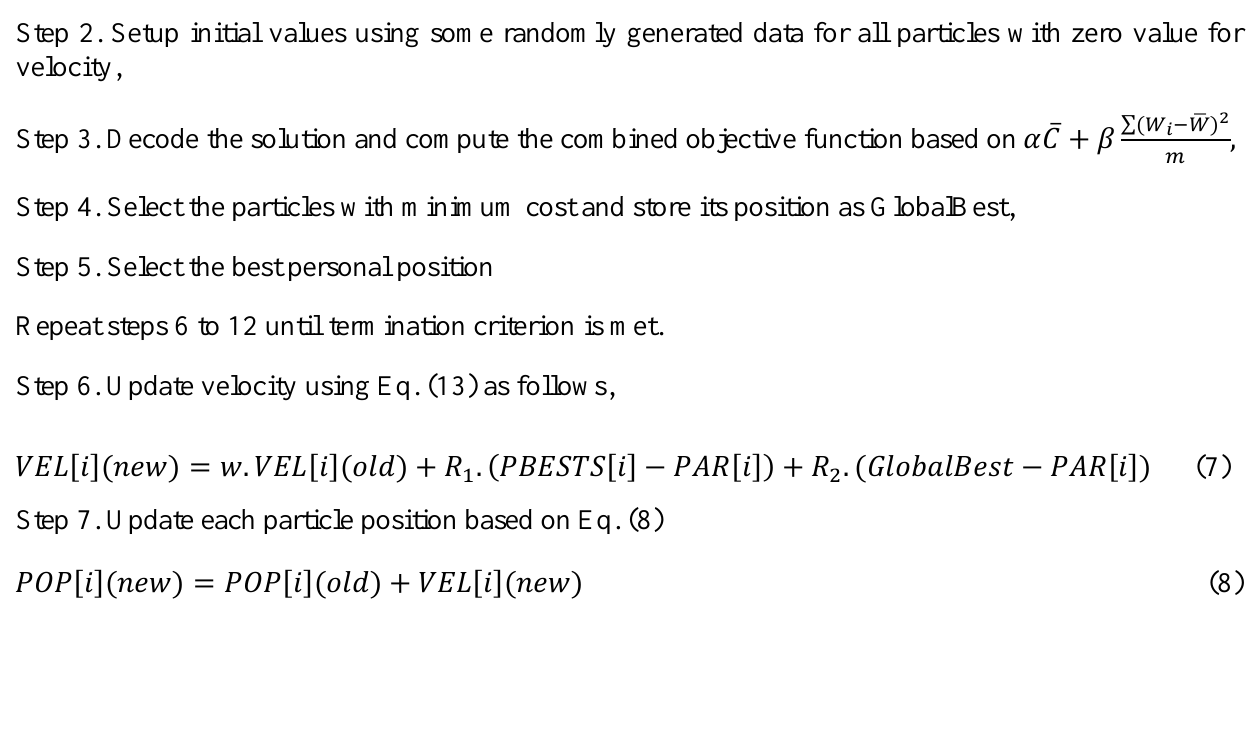
Description Notation of